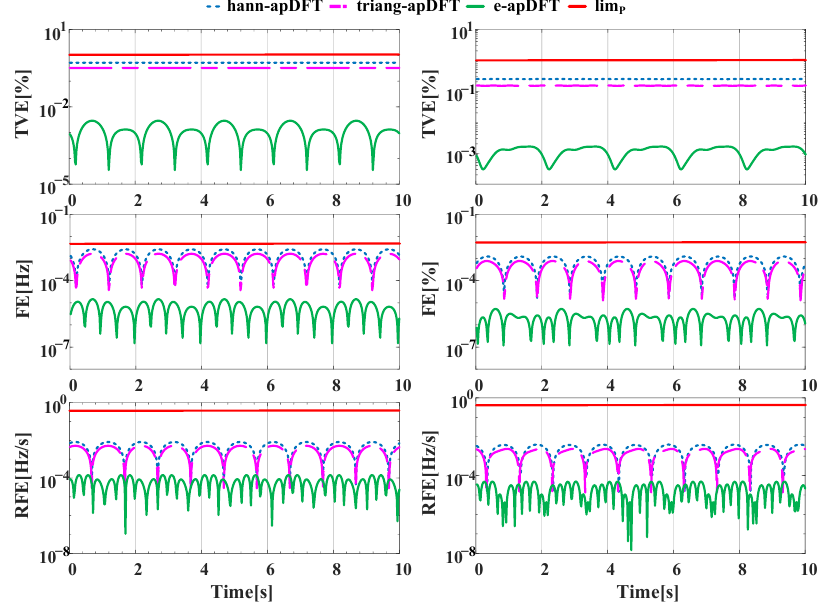
Figure 8. The interference of the DC component and the second harmonic.